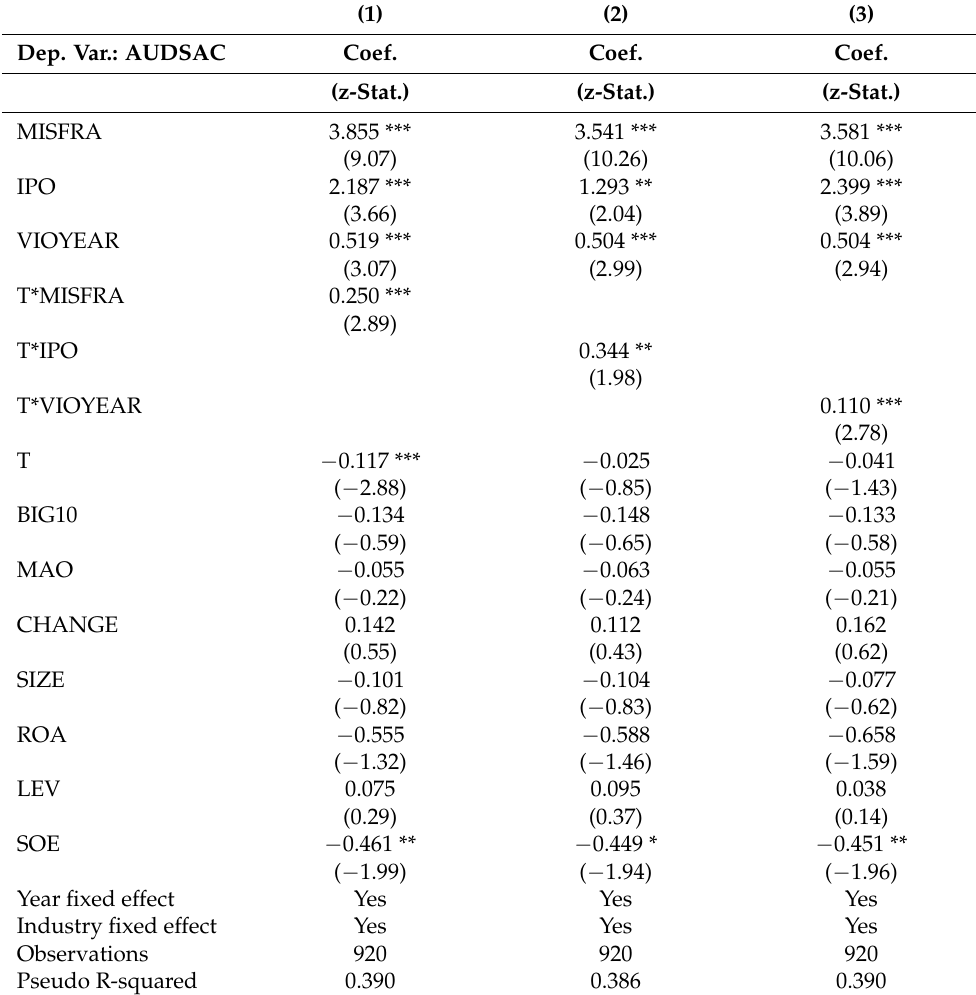
Table 5. Regression results of the time trend of supervision intensity.